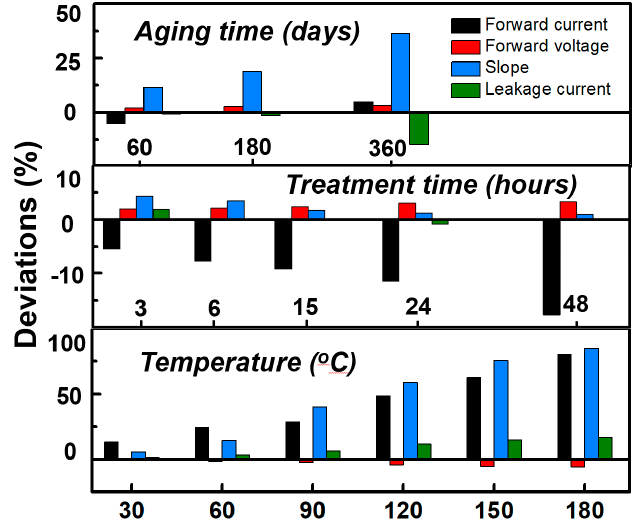
Figure 6. The degradation comparisons of forward current, forward voltage, slope and leakage current under long aging time, high-humidity treatment, and high-temperature conditions. Table 1. Reliability test results of micro-LED devices under di ff erent